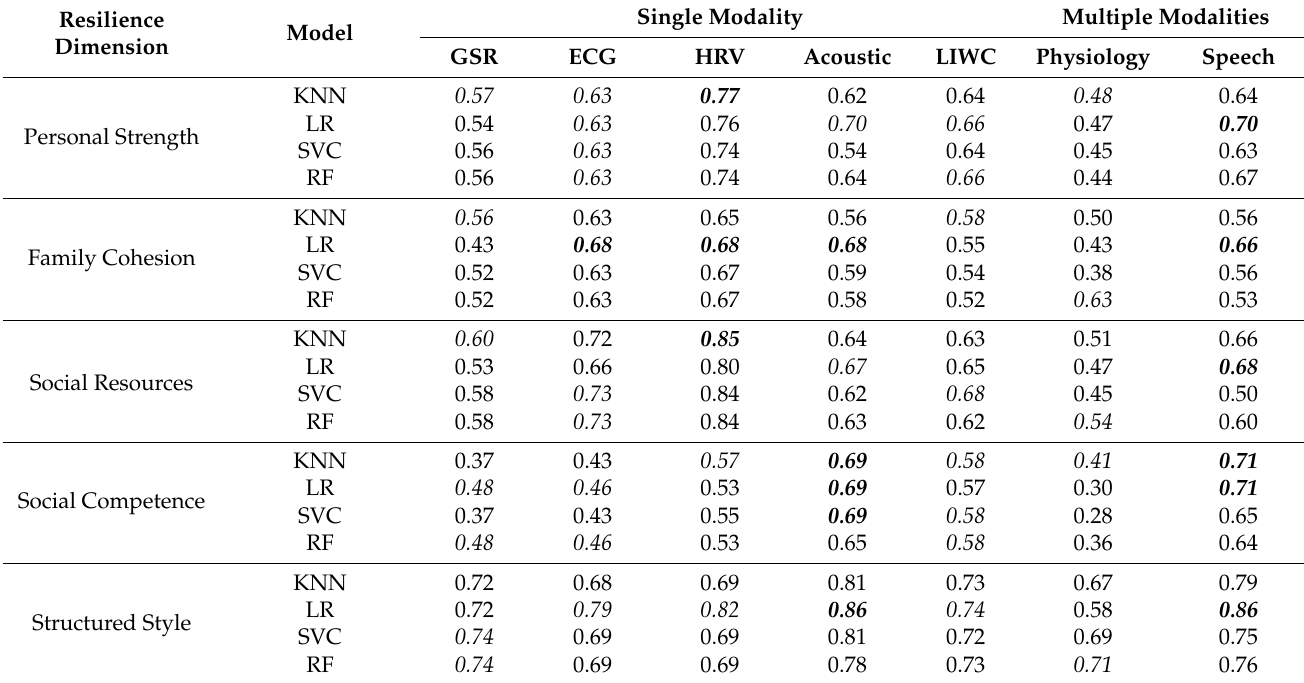
Table 4. Results of Resilience Estimation ( positive and negative memories